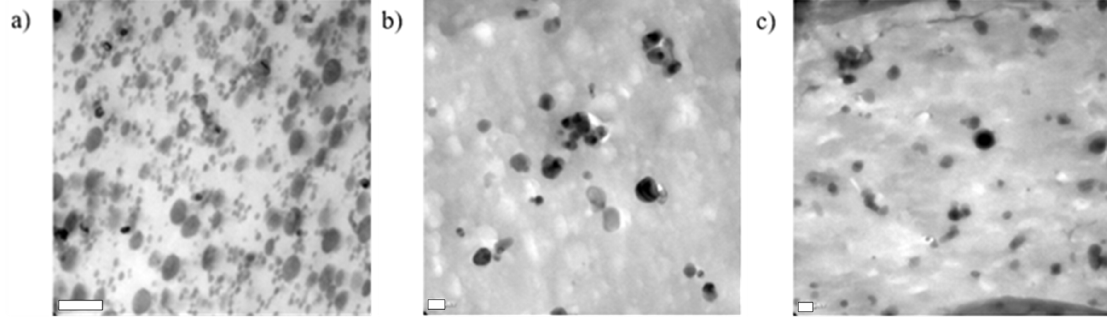
Figure 7. TEM micrographs of pure ABS ( a ), ABS/1.5CNC C150 ( b ), and ABS/1.5CNC D150 ( c ). Scale bar equal to 0.2 µm.